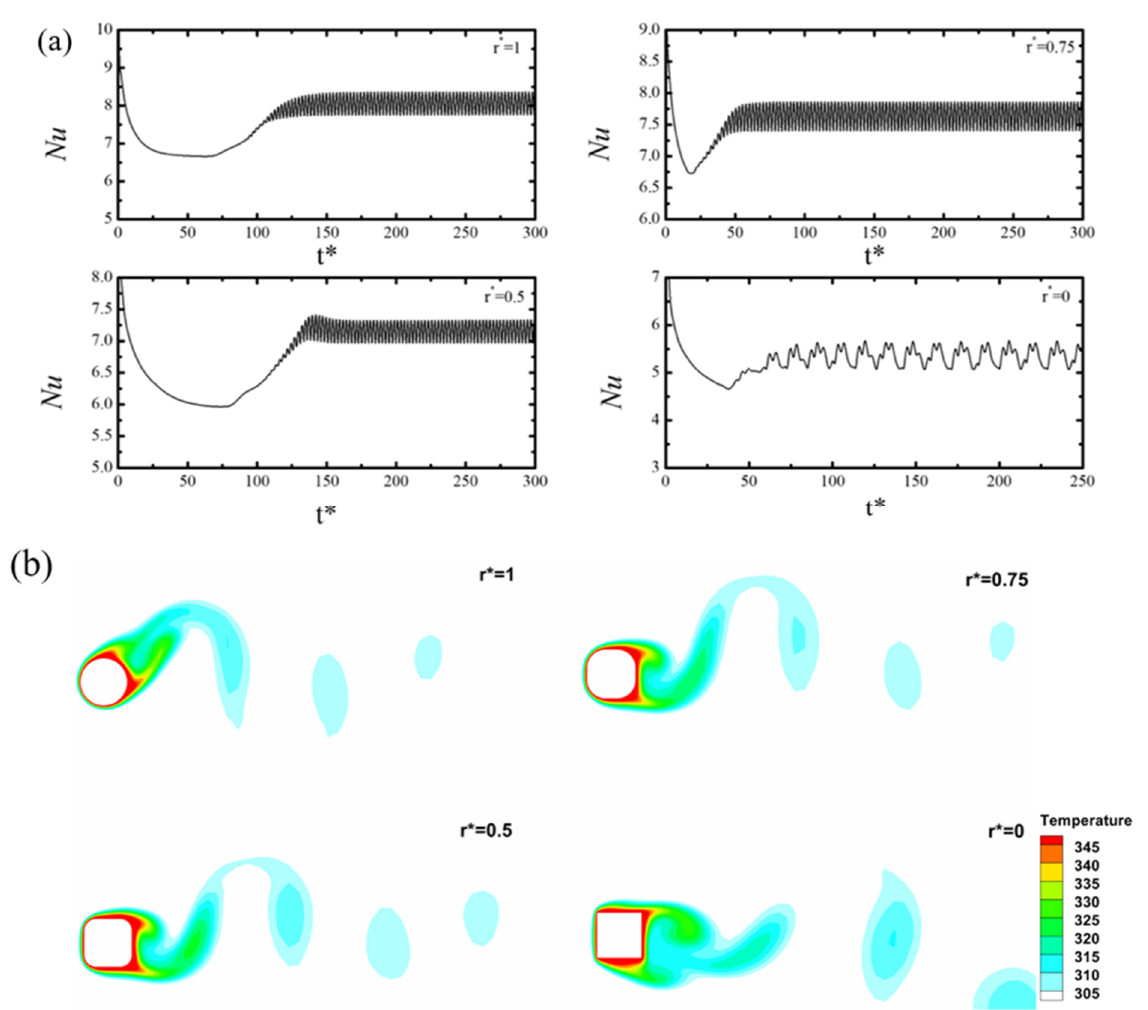
Figure 13. Effect of r* on heat transfer with vortex-induced vibration at Re = 200 and 𝑈𝑟 = 4.92 . ( a ) Time histories of the lift coefficient. ( b ) Temperature contour of the different radius corners.